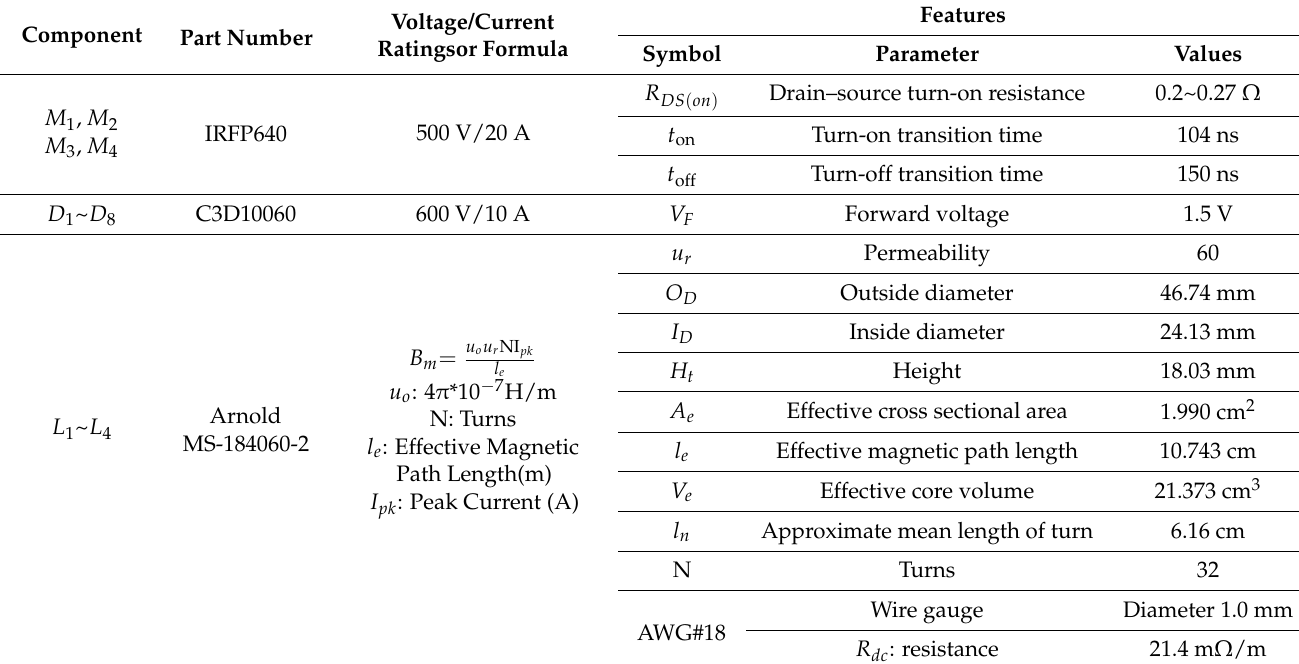
Table 4. Semiconductor loss analysis for the proposed boost converter under input voltage of AC 100 V.